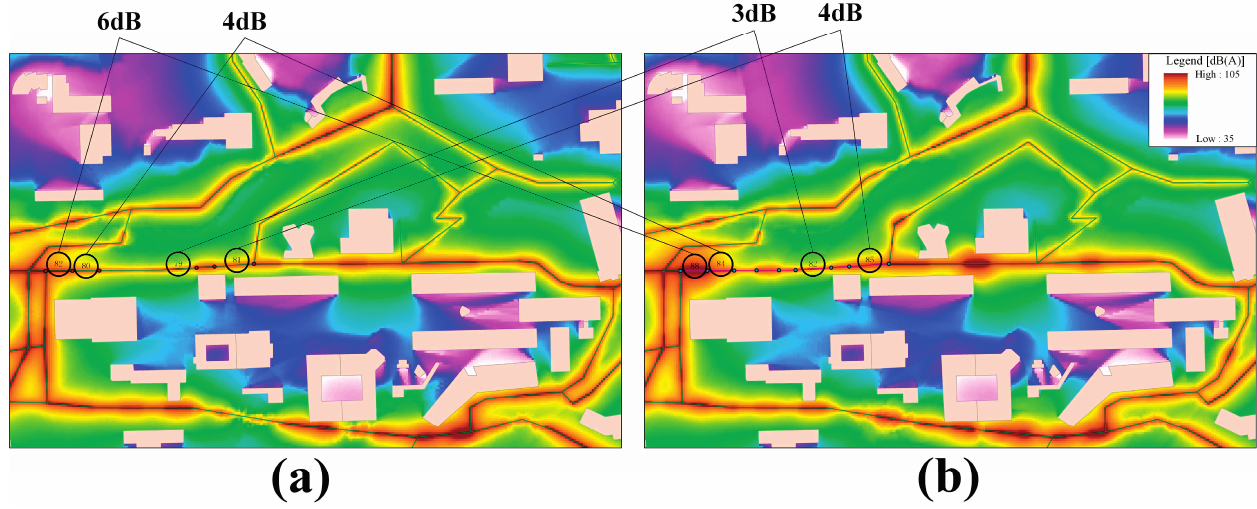
Figure 9. Simulation results for the noise distribution in a local area of the CUHK campus. ( a ) One day and ( b ) one